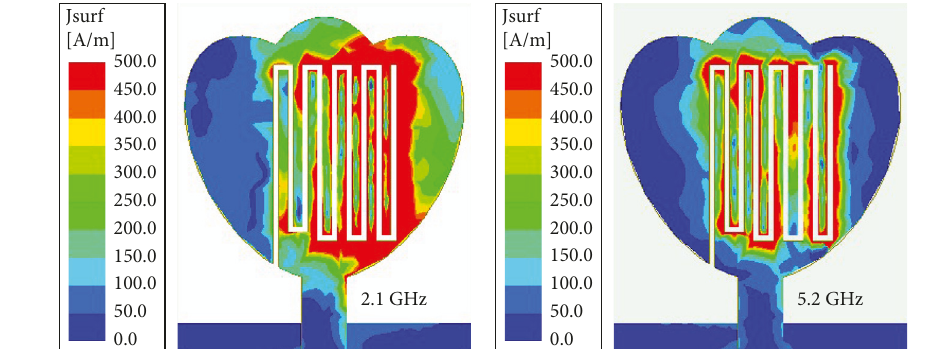
Figure 6: Current distribution of the proposed MSB antenna.